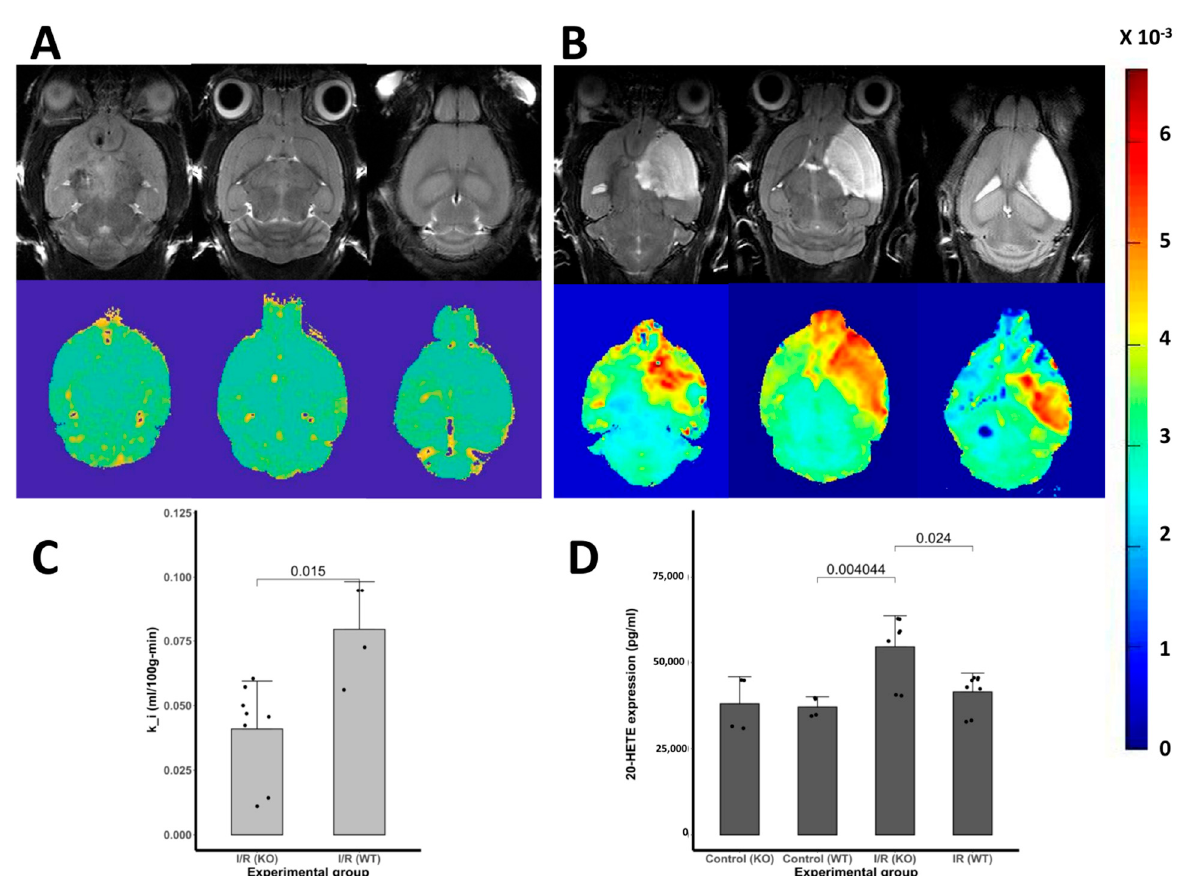
Figure 6. Ischemia/reperfusion triggers an increase in 20-hydroxyecosatetraenoic acid (20-HETE) synthesis and breakdown of the blood-brain barrier (BBB) in the brain of mice. ( A ) Representative BBB transfer rate map after I/R in CYP2E1( − / − ) and ( B ) in WT control mice, in vivo MR quantification. Representative structural MRI (above) and corresponding quantitative BBB transfer rate map (below) are shown for three consecutive slices covering most of the ischemic lesion for both CYP2E1( − / − ) and WT MCAo. Panel ( C ) represents a statistical comparison of BBB transfer rates between CYP2E1( − / − ) MCAo and WT MCAo as measured by MRI. Furthermore, 20-HETE synthesis following the insult of I/R was increased significantly ( p < 0.05) in CYP2E1( − / − ) mice (36% of control). However, the 20-HETE synthesis increment in WT- I/R was not statistically significant compare to WT controls (12% of WT control). Data are presented as mean ± SD in panel ( D ). n = 8–10. Mouse MCAo was subjected to 90 min MCA occlusion and 24 h of reperfusion. In this CYP2E1 ( − / − )